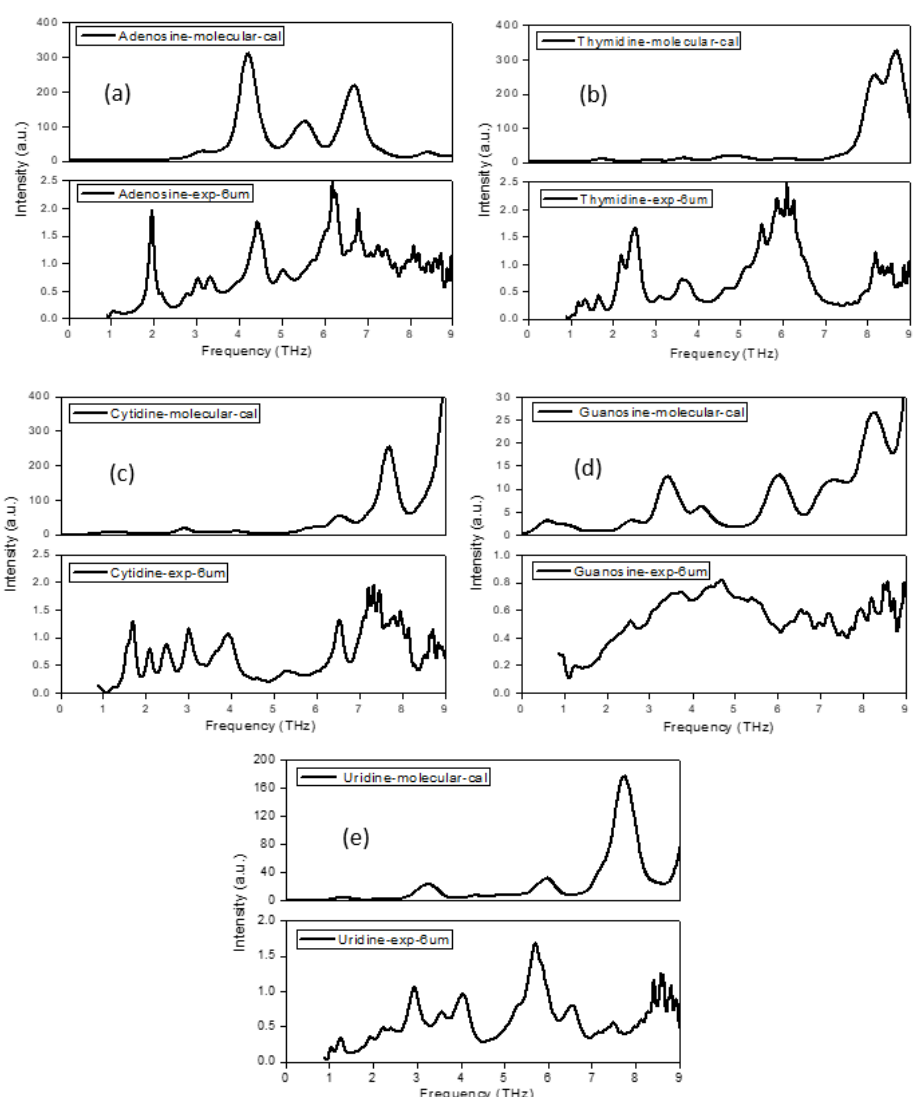
Figure 2. Comparison of calculation (single molecular) and experimental spectra of five nucleosides. Figure 1. Comparison of calculation (single molecular) and experimental spectra of five